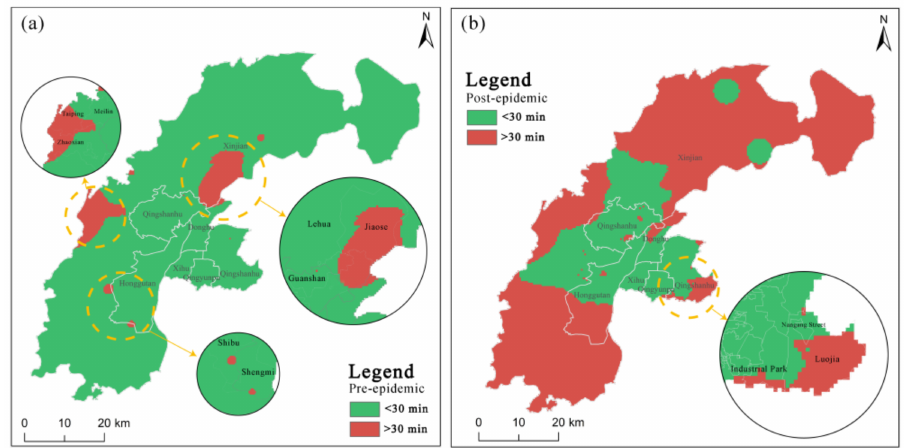
Figure 18. The 30-minute accessibility of residents to outdoor sports venues: ( a ) pre-epidemic; ( b ) post-epidemic.